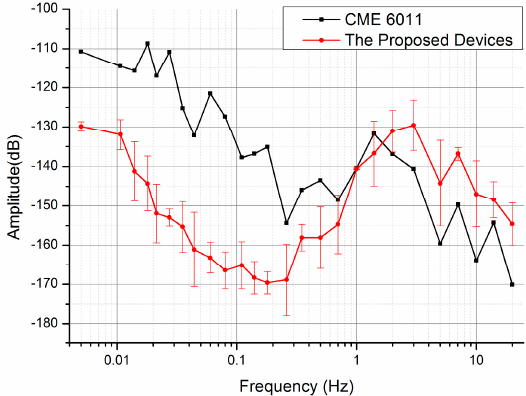
Figure 8. The self-noise power spectrums of the developed MEMS electrochemical seismic sensors with feedback (n device = 6) and the conventional CME 6011 where the developed seismic micro sensors device produced lower self-noise levels than CME 6011 in the frequency domain of 0.01–1 Hz.